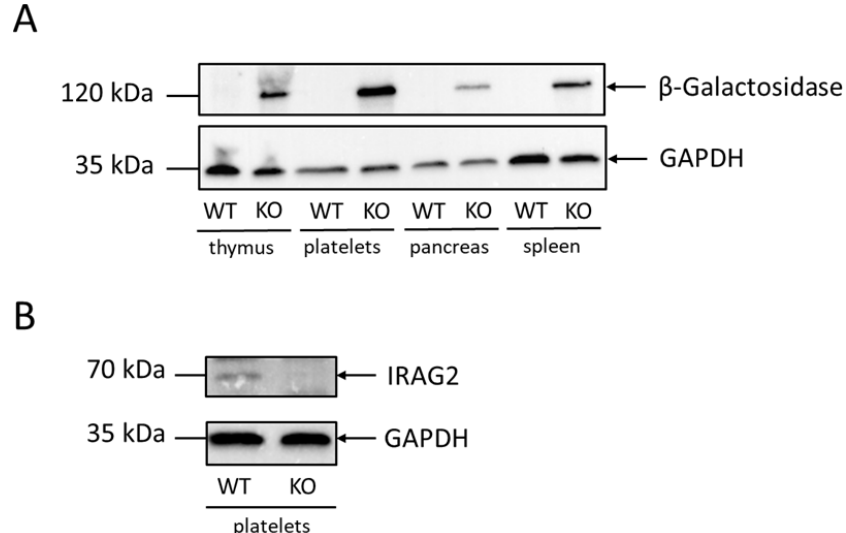
Figure 1. Expression of IRAG2 in murine platelets. ( A ) Western Blot analysis revealed expression of β-Galactosidase as a reporter for IRAG2 in thymus, platelets, pancreas and spleen from lacZ × IRAG2-KO mice (KO); no signal was detected in tissues from IRAG2-WT mice (WT). ( B ) Ex- pression of IRAG2 was confirmed by Western Blotting using an IRAG2-specific antibody. IRAG2 was detected in platelets from IRAG2-WT mice (WT) but not in platelets from IRAG2-KO mice (KO). GAPDH was used as a loading control ( A , B